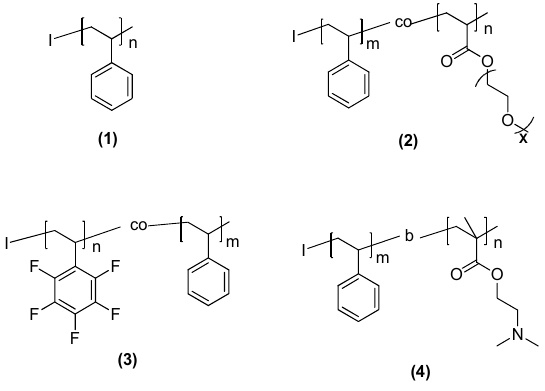
Figure 1. Chemical structures of the polymers employed in this study: ( 1 ) homopolystyrene; ( 2 ) polystyrene- co -poly(polyethylenglycol methacrylate) (PS- co -PPEGMA) ( 3 ) polystyrene- co -poly(2,3,4,5,6-pentafluorostyrene) (PS- co -P5FS) and ( 4 ) polystyrene- b -poly(dimethylaminoethyl methacrylate).